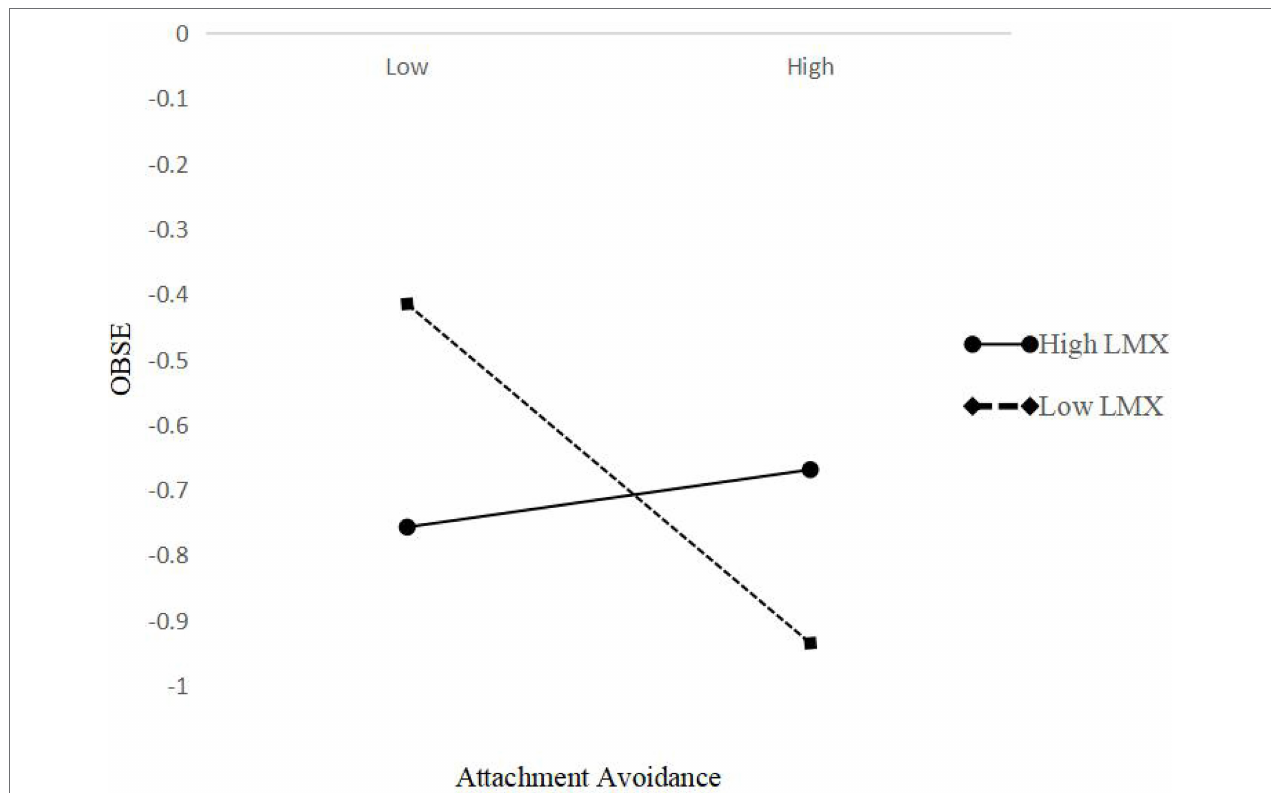
FIGURE 4 | Interactive effects of attachment avoidance and leader–member exchange (LMX) on organization-based self-esteem (OBSE).